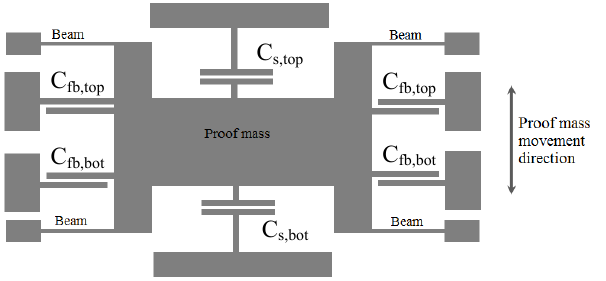
Figure 10. Block diagram of the MEMS sensing element.